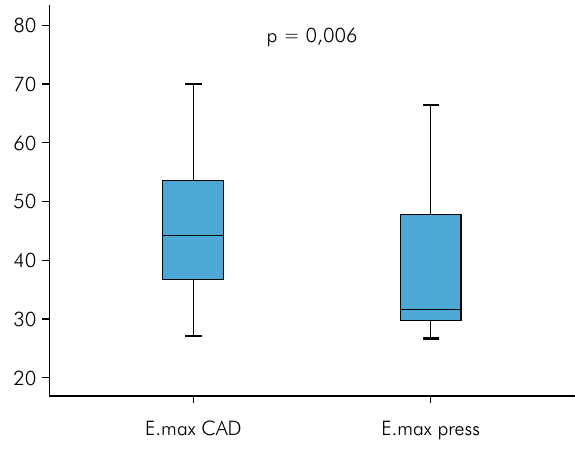
Figure 3. Data distribution. The horizontal line in the boxes represents the median value.